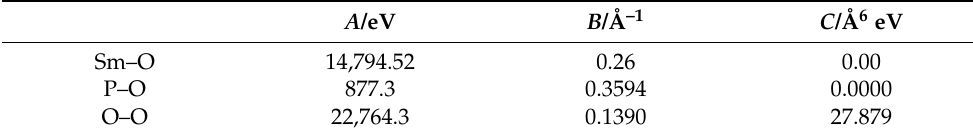
Table 1. Buckingham potential parameters used in the simulations.